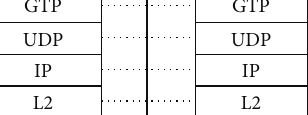
denial-of-service (DoS) attack scenarios on mobile networks